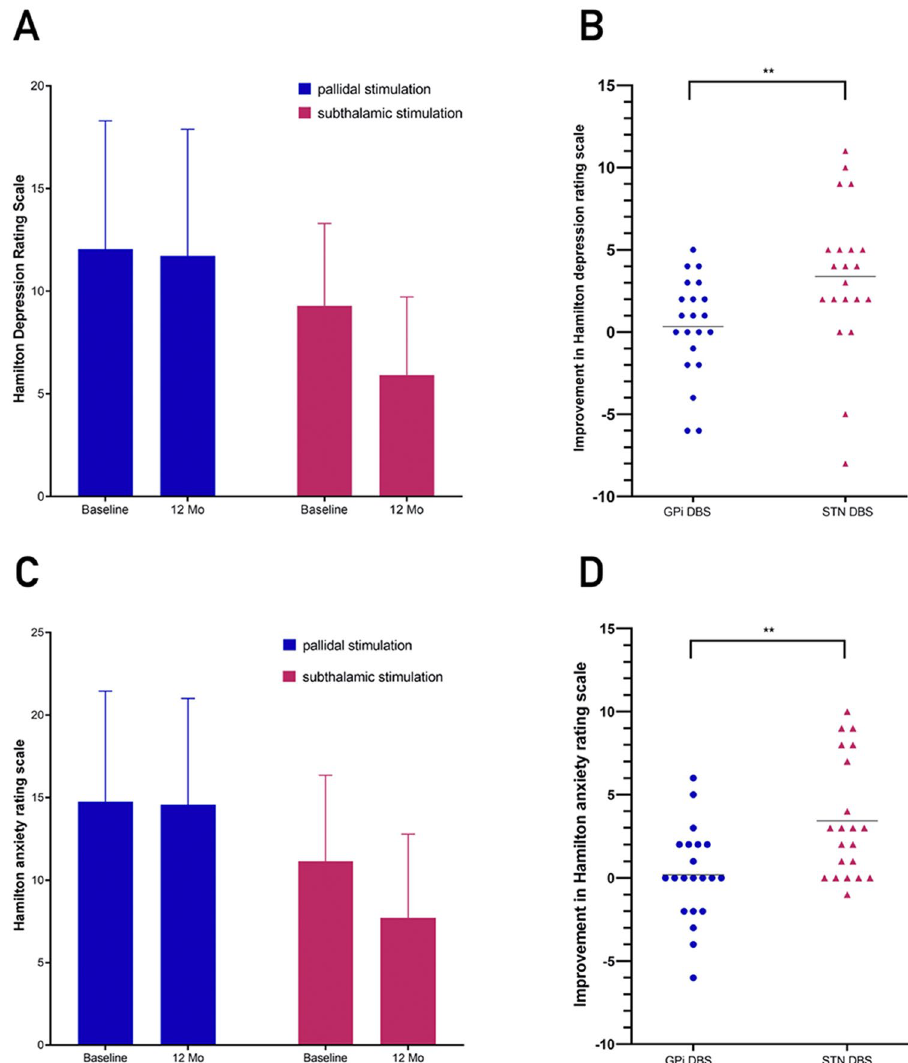
Figure 4. The effects of STN-DBS and GPi-DBS on depression and anxiety symptoms based on the 17-item Hamilton depression rating scale (HAMD) scores (scores range from 0 to 52, with higher scores indicating more severe depression) and 14-item Hamilton anxiety rating scale (HAMA) scores (scores range from 0 to 56, with higher scores indicating more severe anxiety). (A) HAMD scores for patients with STN-DBS and GPi-DBS at baseline and the last follow-up. (B) The comparison in efficacy for clinical improvement based on HAMD scores between STN-DBS and GPi-DBS. (C) HAMA scores for patients with STN-DBS and GPi-DBS at baseline and the last follow-up. (D) The comparison in efficacy for the clinical improvement based on HAMA scores between STN-DBS and GPi-DBS. "**" indicates P <